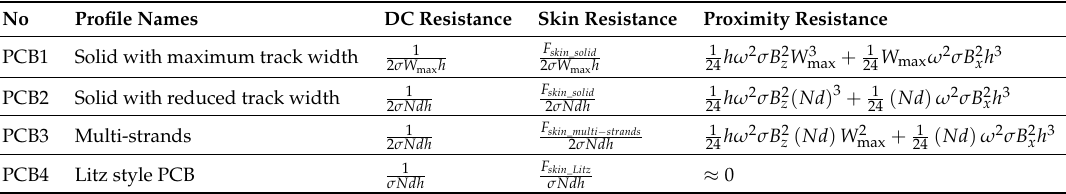
Table 2. Per unit length resistances of each turn of different